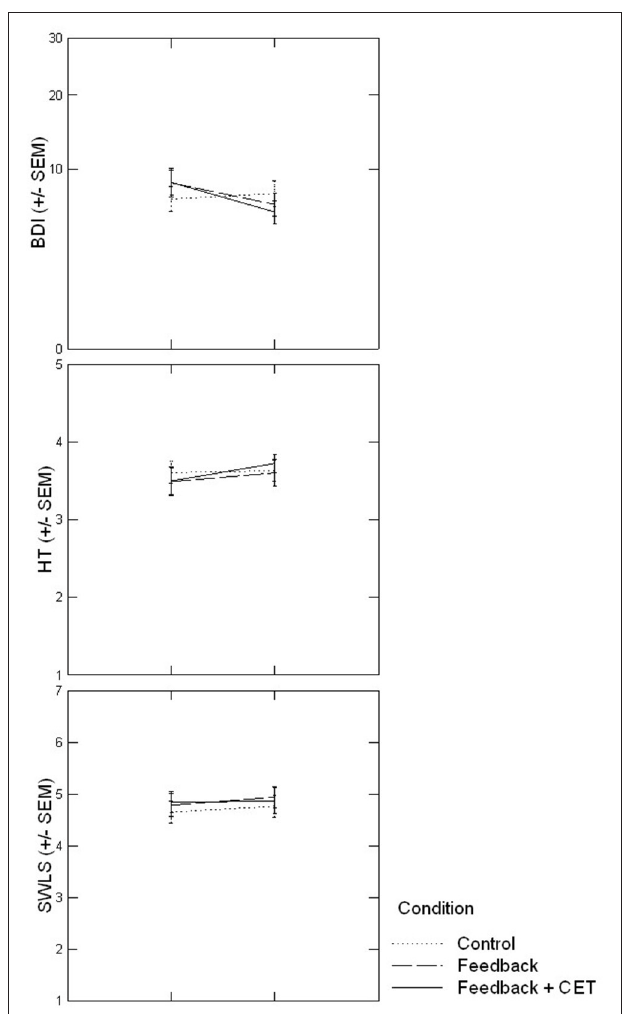
FIGURE 3 | Time × Condition effects on three measures of well-being. CET, Congruence-enhancement